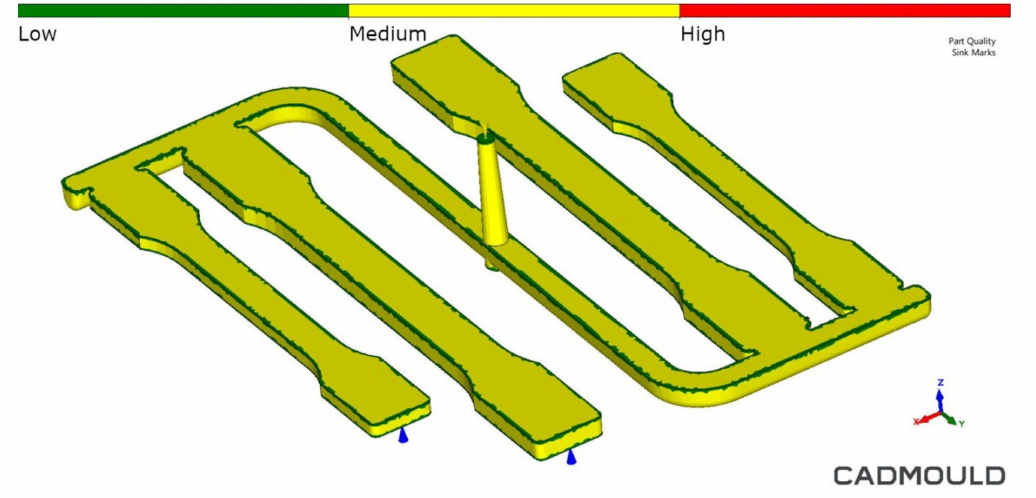
Figure 12. Simulated final sink marks distribution on the foamed PA66 GF30 parts surface.